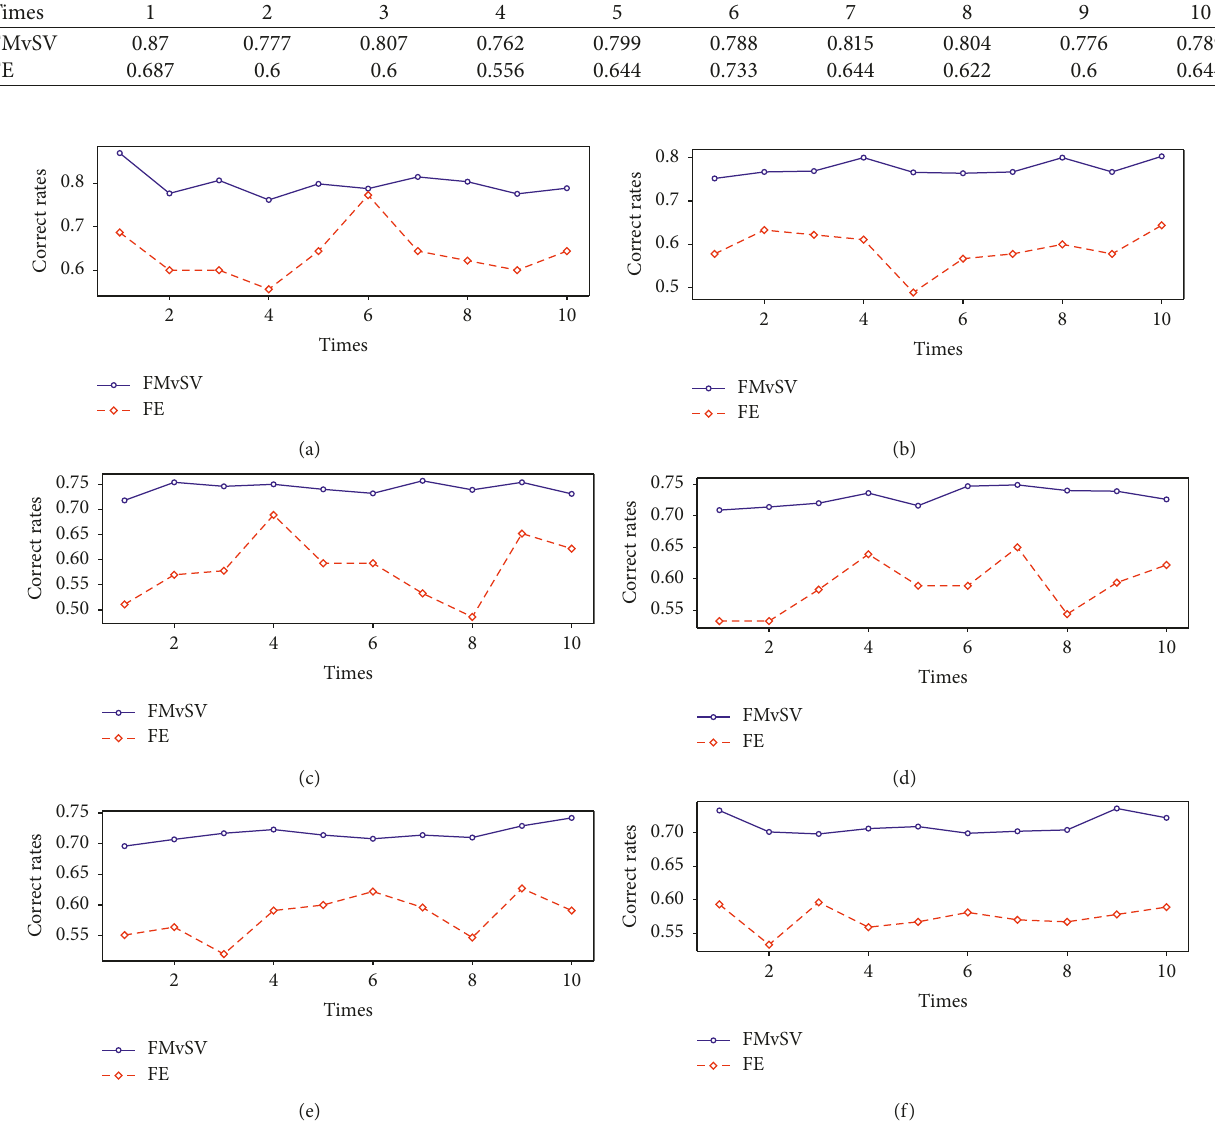
Figure 1: Comparison of the correct rates of Algorithms FMvSV and FE in terms of AD200 with 2 . 5% − 15% missing values. (a) 2.5% missing values. (b) 5% missing values. (c) 7.5% missing values. (d) 10% missing values. (e) 12.5% missing values. (f) 15% missing values.